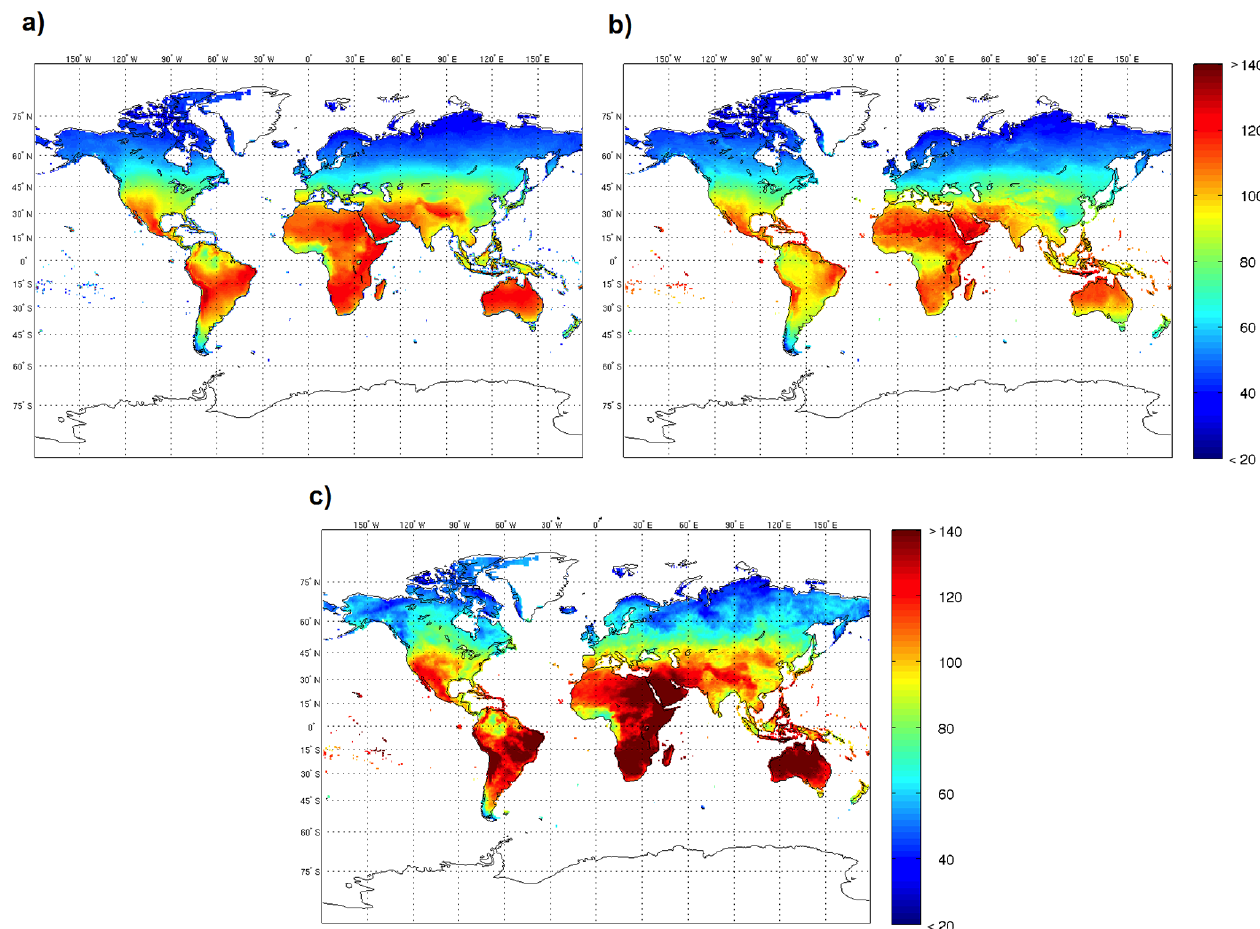
Figure 7. Comparison of photosynthetically active radiation (Wm − 2 ) (a) provided by the MERRA reanalysis, (b) derived from satellite observations (University of Maryland, R. Pinker, personal communication, 2012), (c) calculated as half of incoming shortwave solar radiation from MERRA. The annual averages are shown for the year